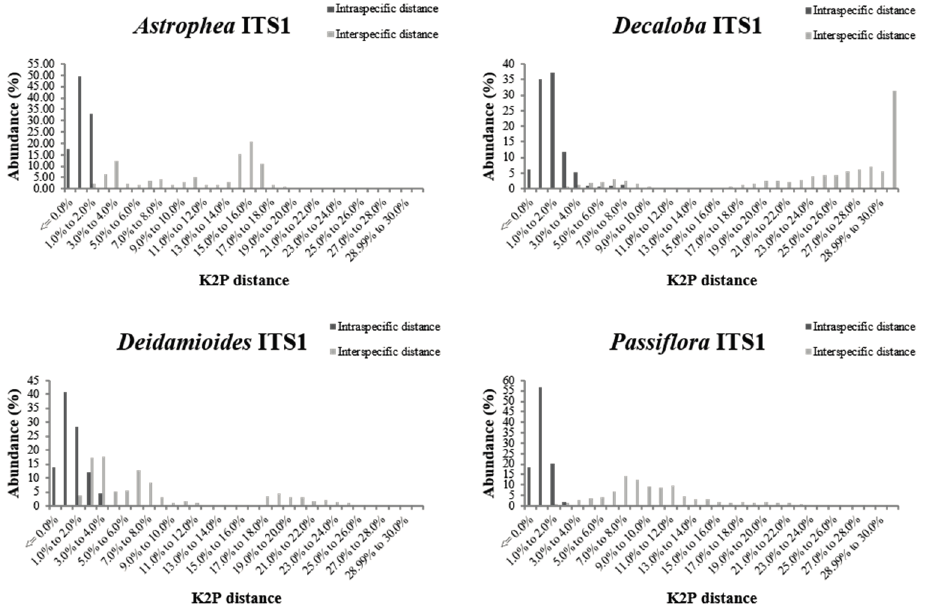
Figure 1. Relative abundance of intra- and inter-specific Kimura-2-Parameter